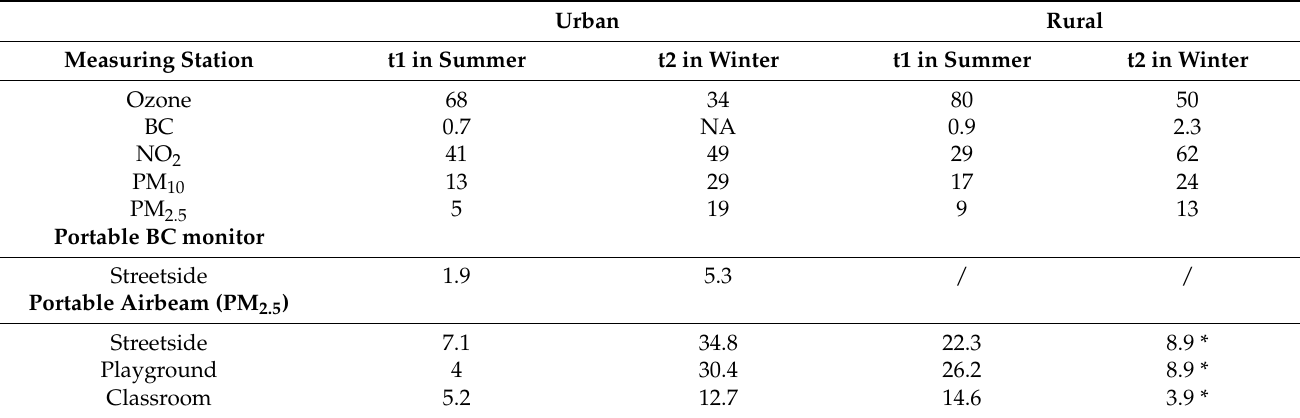
Table 2. Air pollutants, measured at the two time points of the field study. Urban